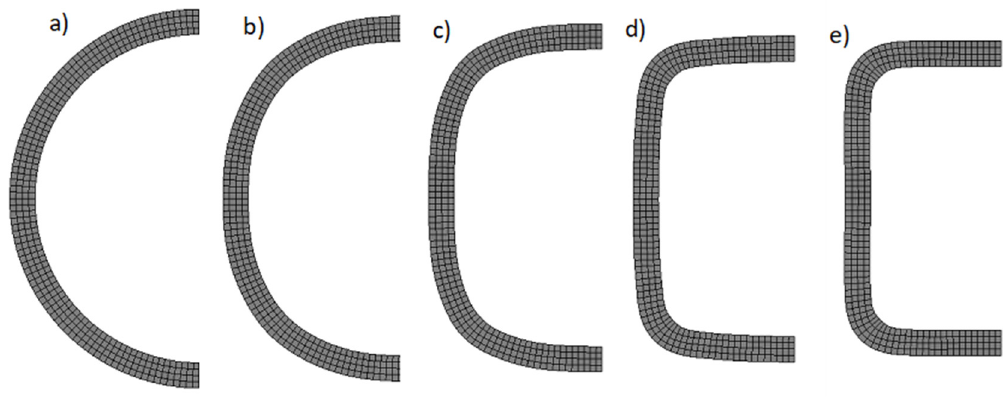
Figure 3. Change in the shape of the cross section of the pipe in the subsequent stages of profiling: ( a ) round pipe, ( b – d ) intermediate shapes; ( e ) square pipe.